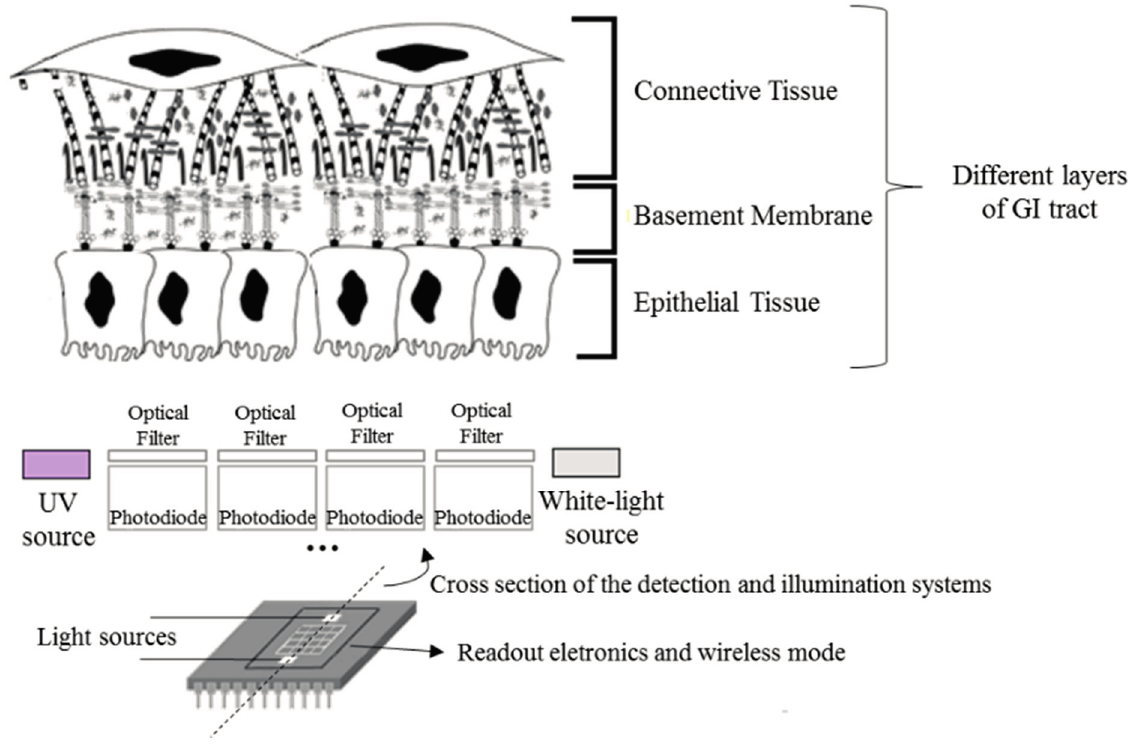
Figure 1. Miniaturized system to be implemented for illumination of gastrointestinal (GI) tissues and detection of diffuse reflectance and fluorescence signals in specific spectral bands, selected by the optical filters (not scaled, adapted [10,11]). Ultraviolet (UV) and white-light sources are required for fluorescence and diffuse reflectance measurements